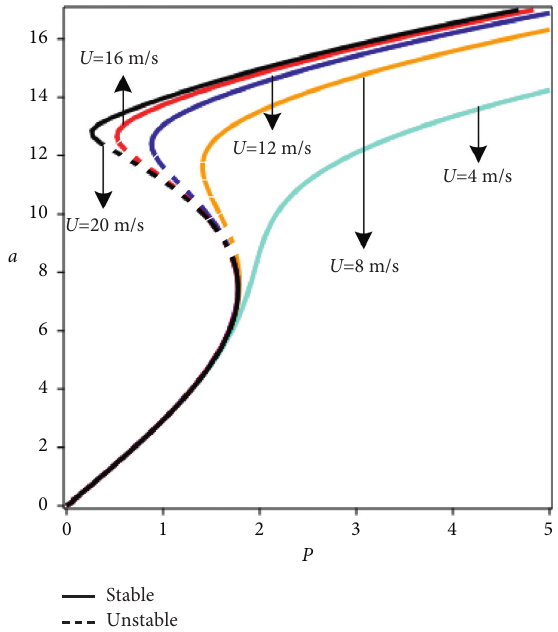
Figure 8: The curves of excitation amplitude ( p ) and response amplitude ( a ) (varied U , σ �−